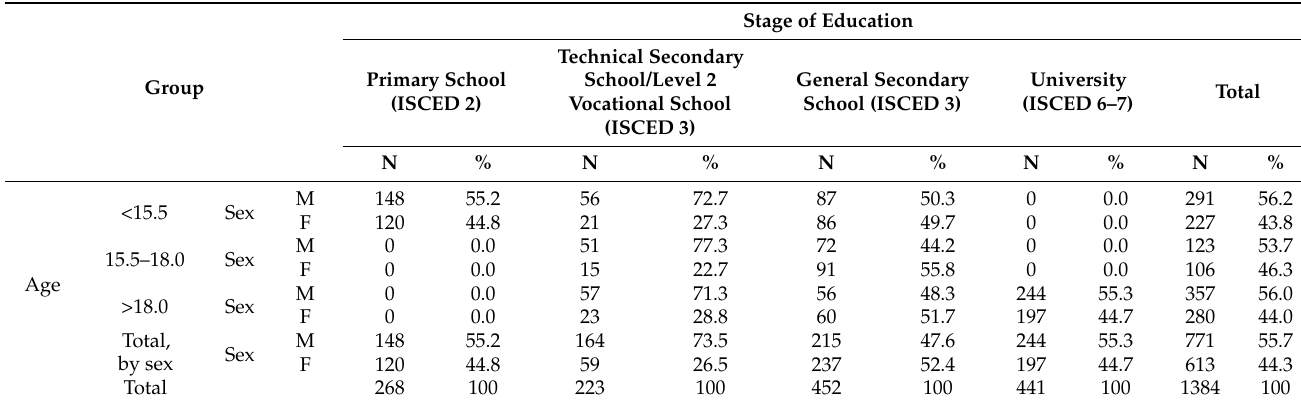
Table 1. Structure of the research